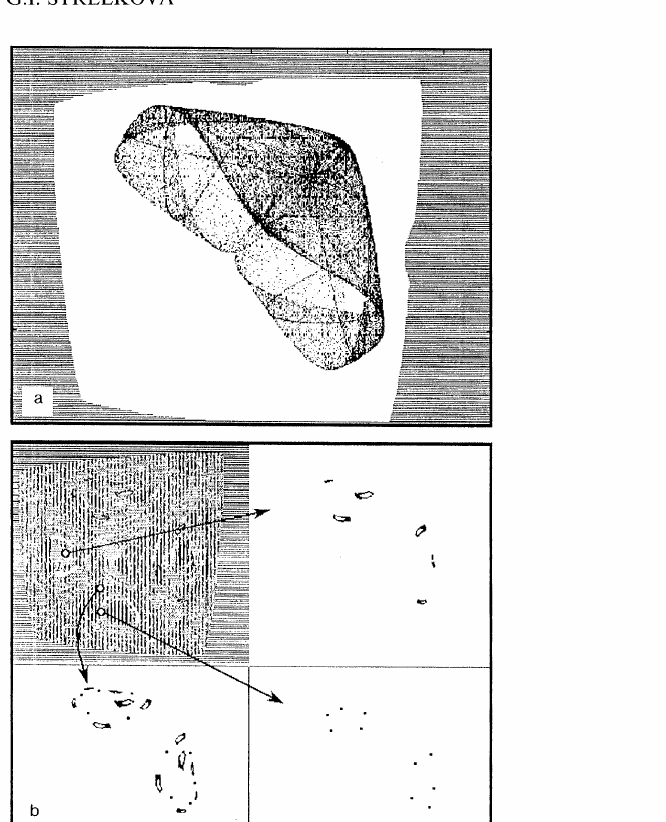
FIGURE 12 Hyperchaos in system (7) for parameters c =0.9, 7 =0.285 (a), the regime of the co-existence of attrac- tors and the structure of the basins of their attraction in sys- tem (7) as c =0.78, g =0.2876 (b) in phase space (xn, yn). The numbers 1,2,3 denote the regions of uncertainty in initial conditions leading to the corresponding limit sets indicated by